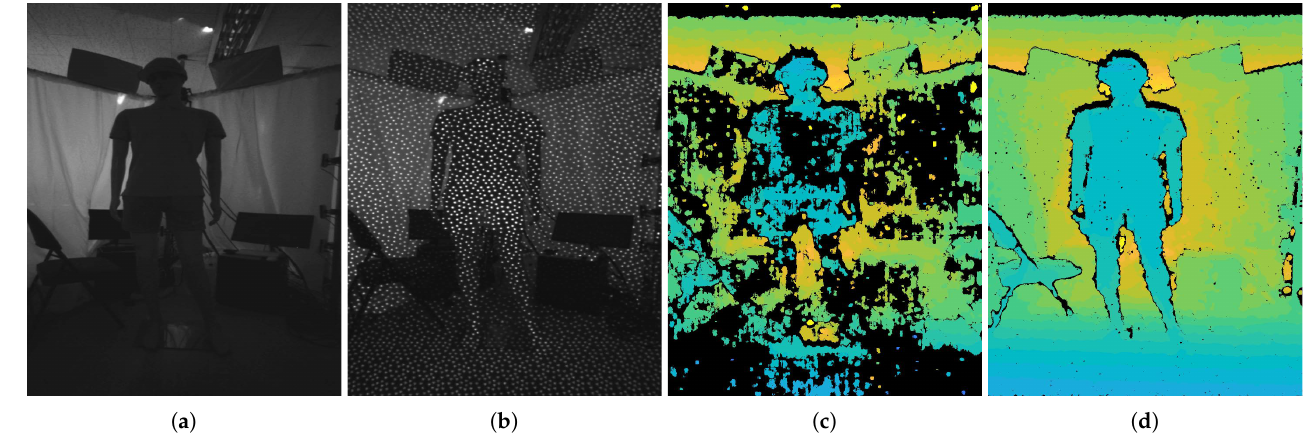
Figure 1. Depth estimation results with and without the active pattern. The active pattern increases the depth estimation accuracy by providing additional information for calculating corresponding points in textureless regions. ( a ) Non-active image. ( b ) Active image. ( c ) Non-active depth